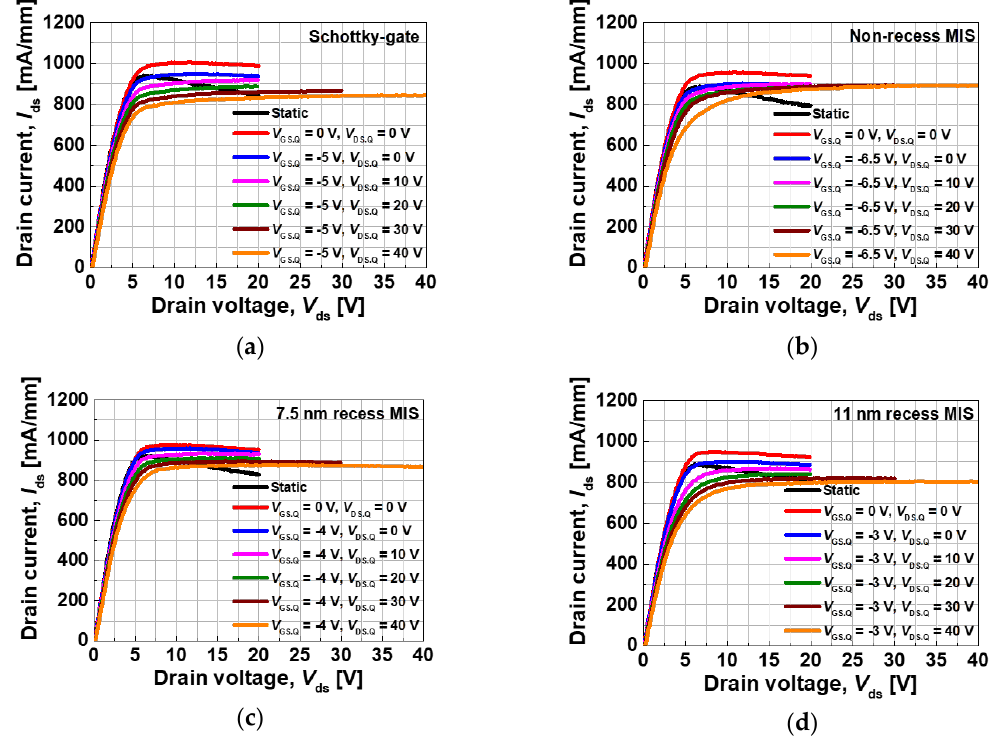
Figure 5. Pulsed I-V characteristics of the fabricated devices; ( a ) Schottky-gate, ( b ) non-recess MIS gate,